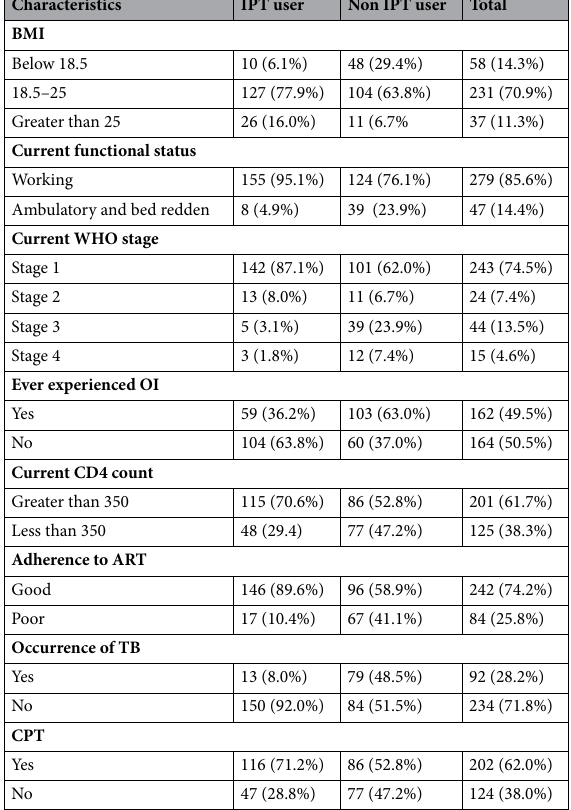
Table 2. Clinical-related characteristics of PLWHIV in Dessie city administrative 2021.